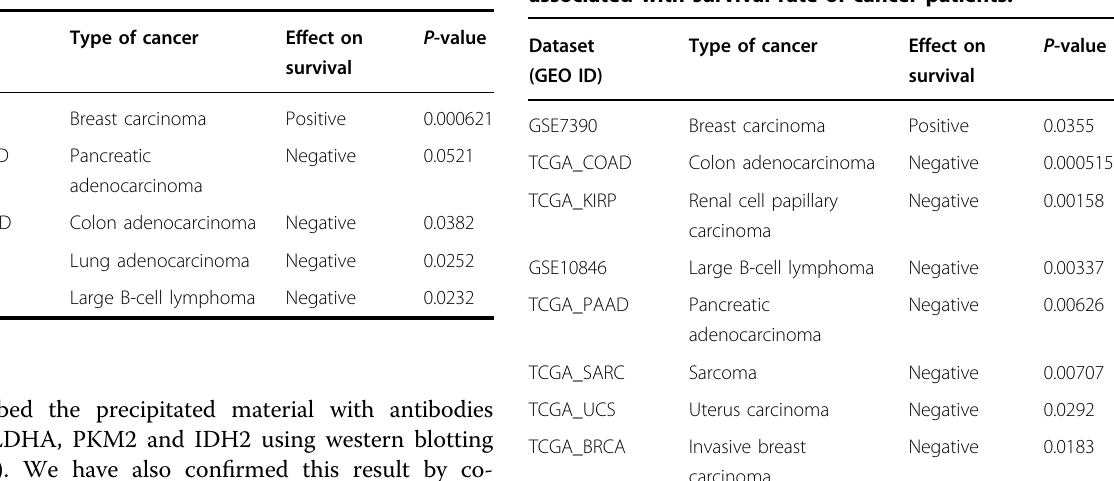
Table 1 The expression level of SEMG1 is negatively associated with survival rate of cancer patients.